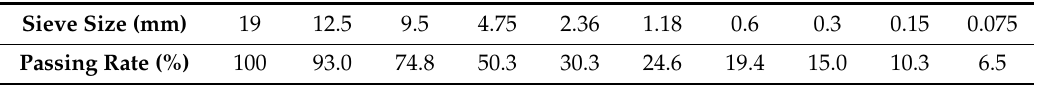
Table 1. Aggregate Gradation of Hot Mix Asphalt